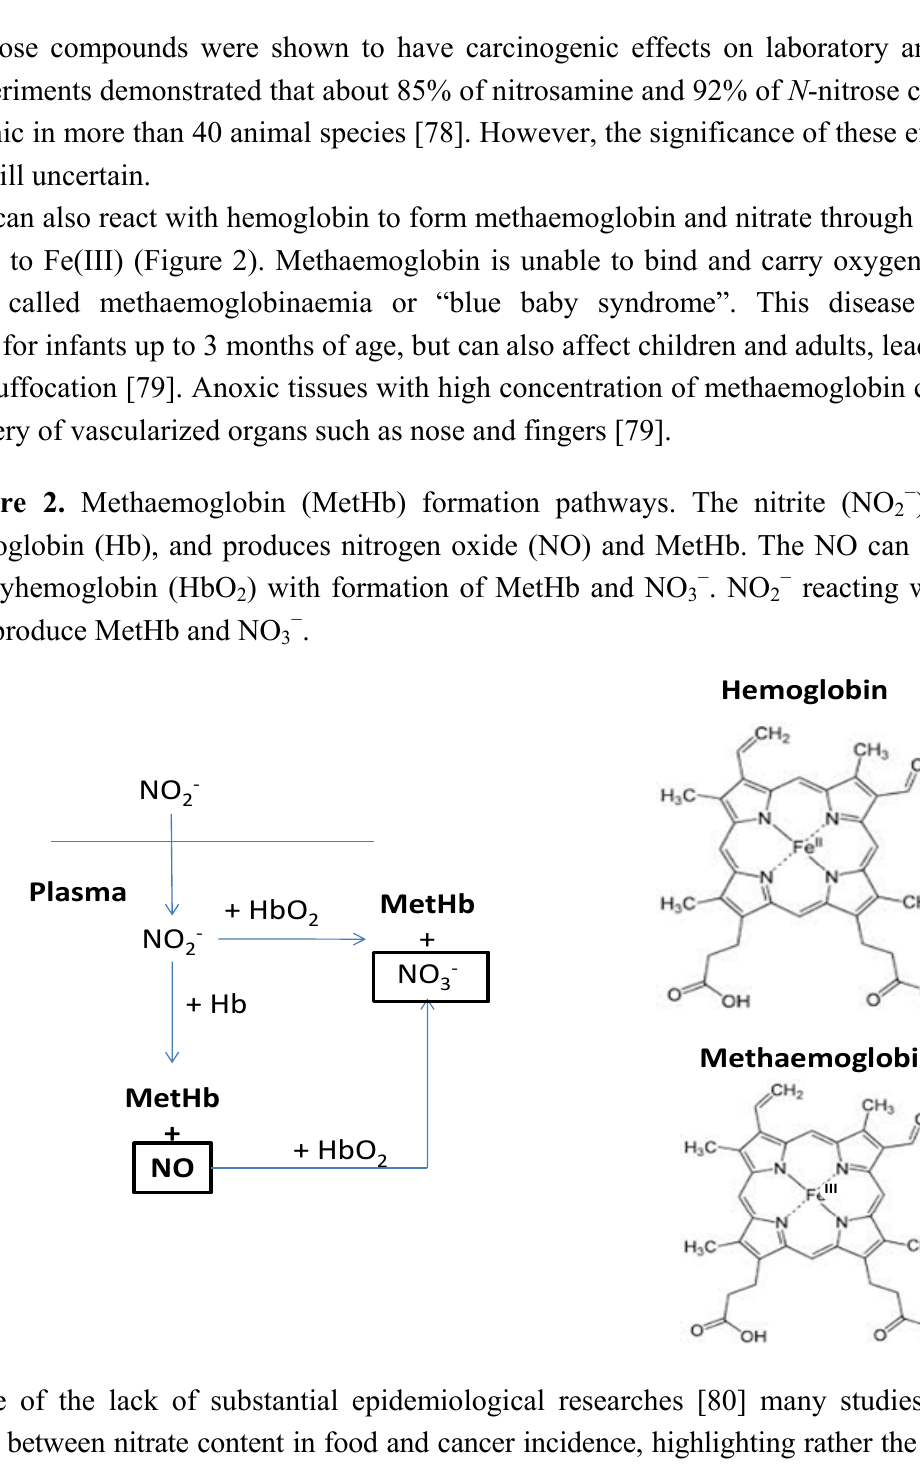
− ) oxidizes 2 − . NO − reacting with HbO 3 2 2